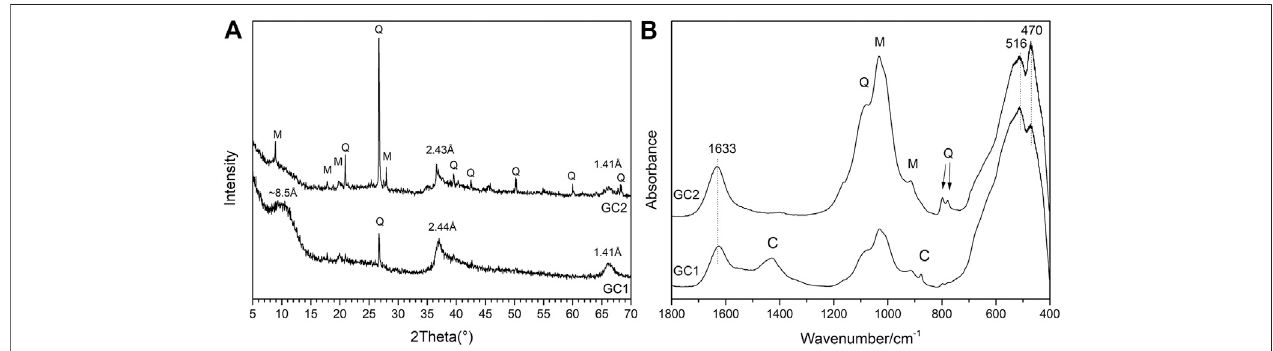
FIGURE 5 | XRPD (A) and FT-IR (B) results from the black layers (GC1) and brown layers (GC2) ( Figure 2 shows the areas selected to extract the material for the analyses). M, mica; Q, quartz, C: carbonate minerals.